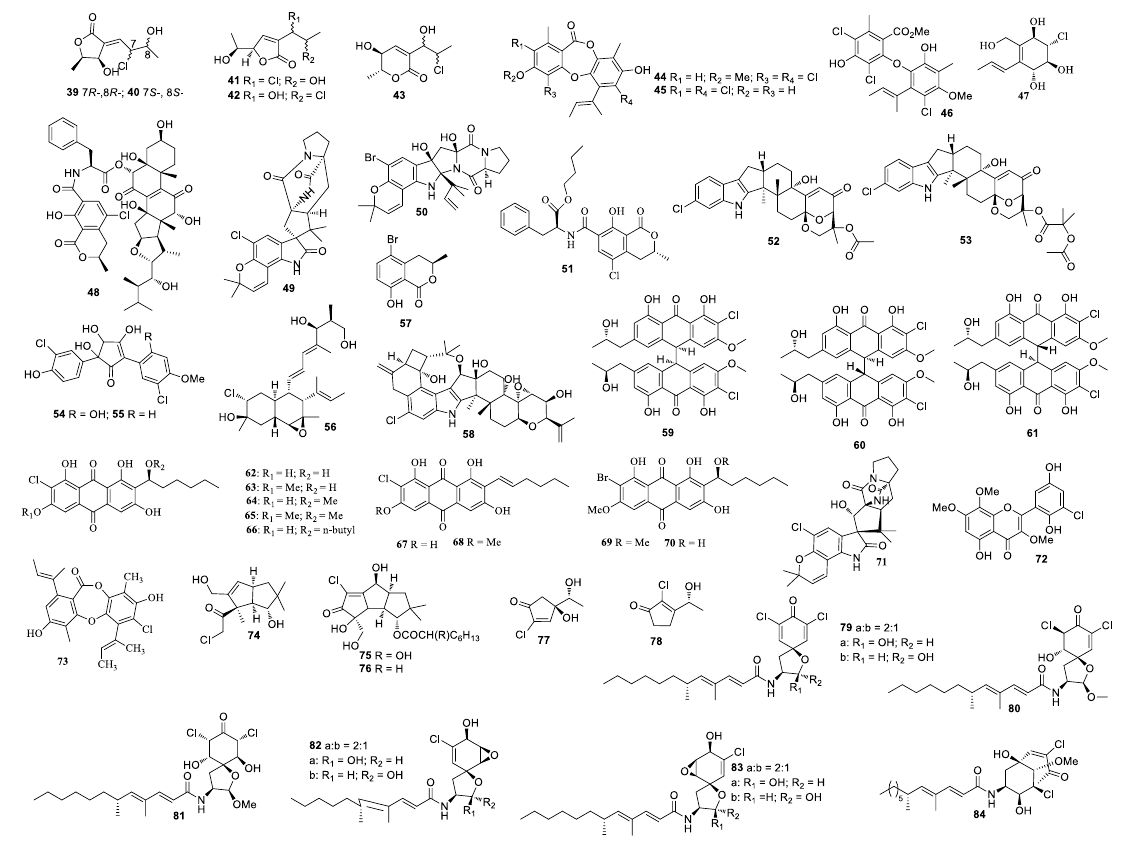
Figure 2. Structures of compounds 39 – 84.